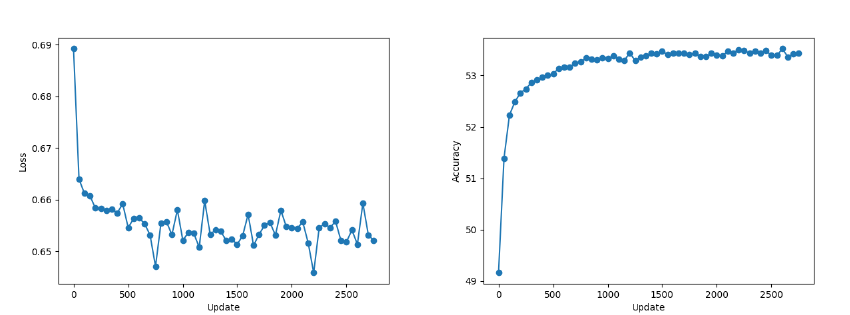
Figure 6. Training Loss (on the left) and Validation Accuracy (on the right) of the TTN in 2 full epochs. (1 epoch = 1440